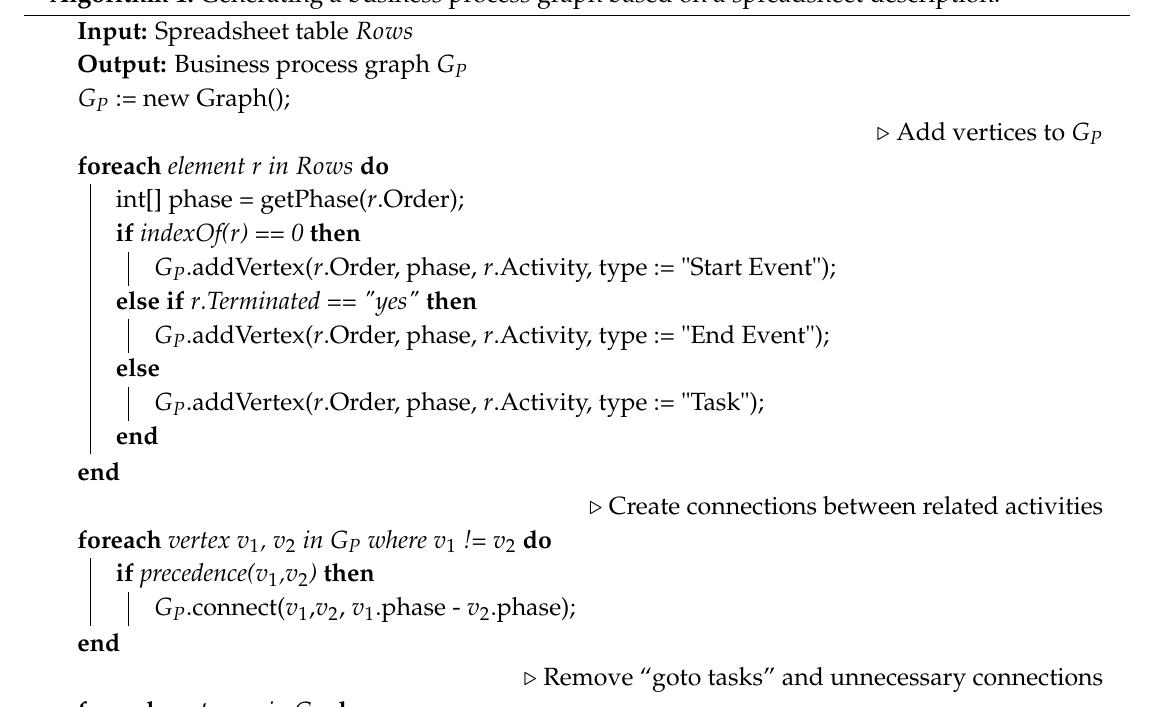
Algorithm 1: Generating a business process graph based on a spreadsheet description. Input: Spreadsheet table